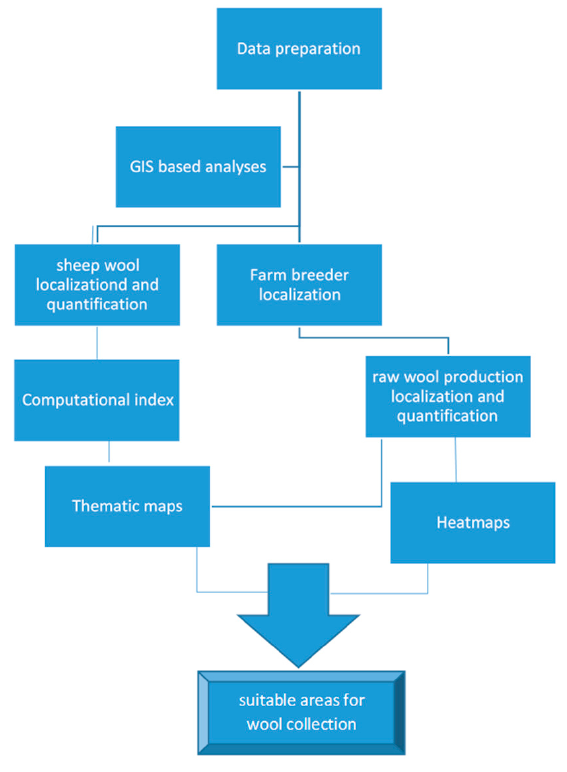
Figure 2. Methodology flow chart.